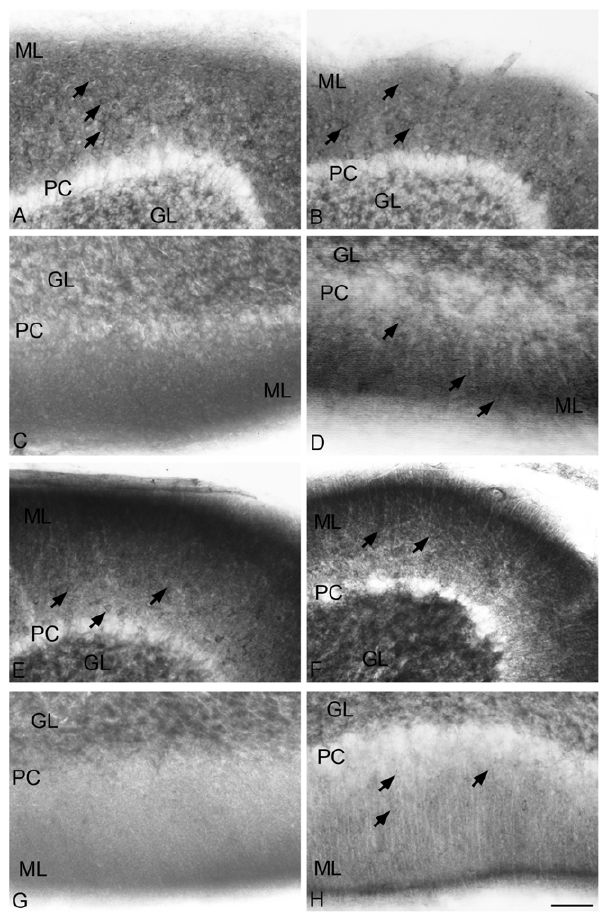
Figure 2. Distribution of NADPH-d stained cells, shown here in black after gray-scale conversion of the original color image, in the molecular layer (ML) of different folia in the vermis region (0.5 mm mediolateral distance) of the cerebellum at P23 and P90. A, C, E and G (SHAM); B, D, F and H (HI). A–D: P23 - A and B, folium 6; C and D, folium 10; E–H: P90 - E and F, folium 6; G and H, folium 10. At P23 and P90, SHAM animals presented a diffuse NADPH-d staining in the ML and a great number of NADPH-d + cell bodies in folium 6 (A and E - arrows). This same pattern is observed in HI animals (B and F - arrows). In folium 10, no labeled cells were seen in the ML of SHAM animals (C and G), whereas HI animals presented a weaker staining in the ML in the same folium and ectopic NADPH-d + cells near the PC, but also in the superficial ML (arrows in D and H). Granular cell layer showed a maintained NADPH-d staining in both groups. ML=molecular layer;